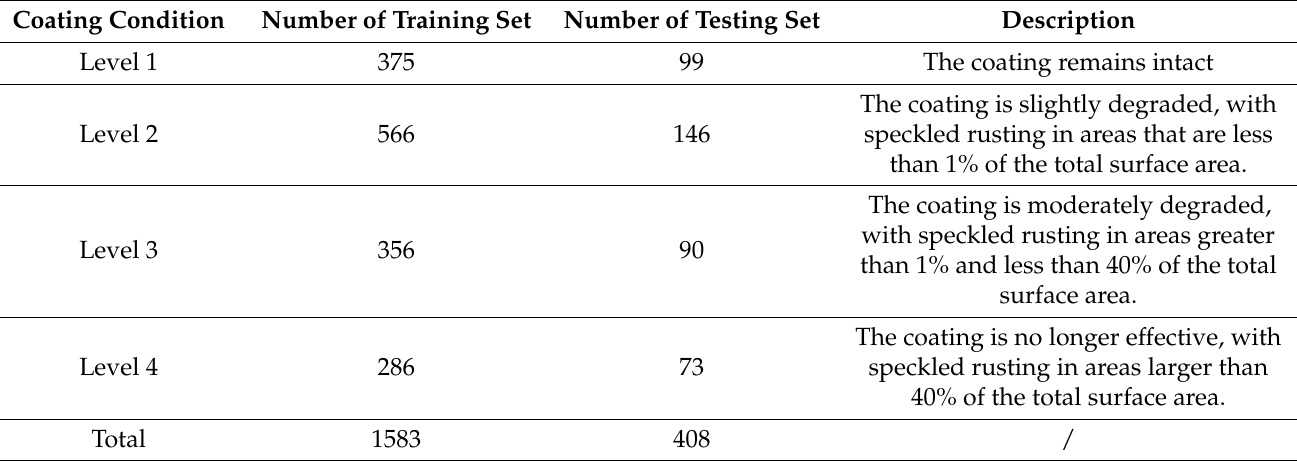
Table 1. The four-level coating condition rating